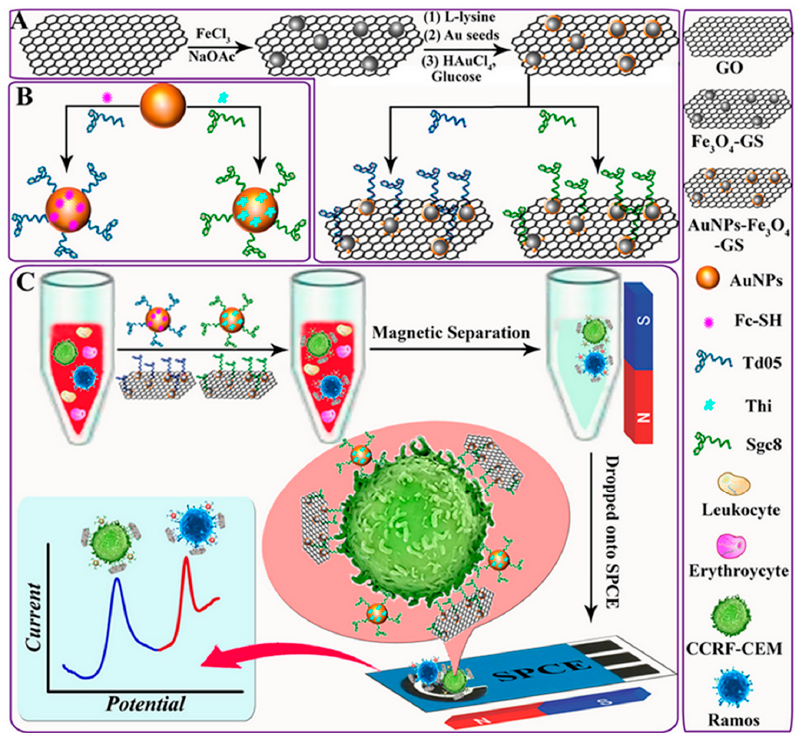
Figure 7. Preparation of ( A ) the aptamer-functionalized AuNPs-Fe 3 O 4 -GS capture probes and ( B ) the aptamer / redox probes functionalized AuNPs. ( C ) Steps of capture, isolation, and multiplexed detection of target CTCs. Reproduced from [80] with permission.